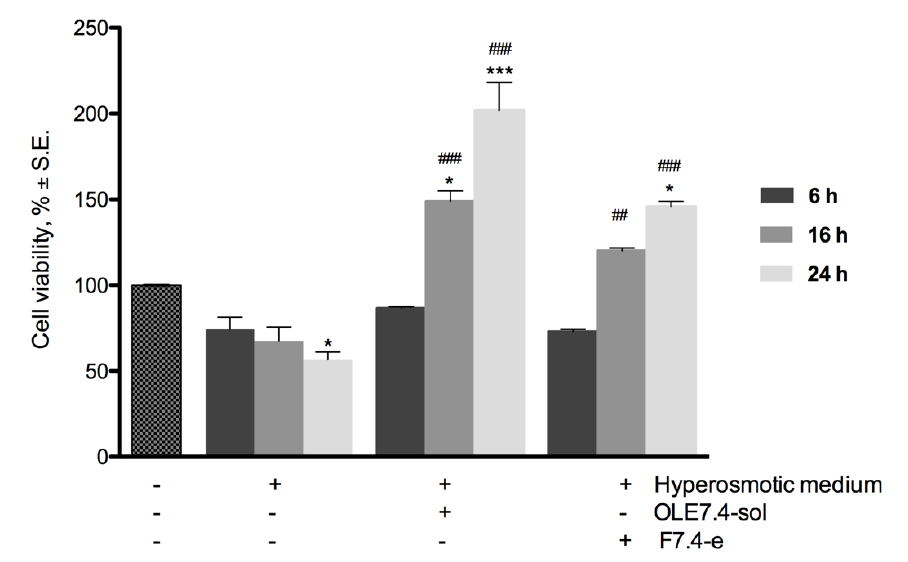
Figure 6. Cell viability of RCE cells pretreated 60 min with OLE formulations and subsequent addition and contact of hyperosmotic medium for 6, 16, and 24 h. * p < 0.05, ** p < 0.01, *** p < 0.001 were considered significant versus the control (untreated cells); # p < 0.05, ## p < 0.01, ### p < 0.001 were considered significant versus the cells in hyperosmotic medium for the same contact times.